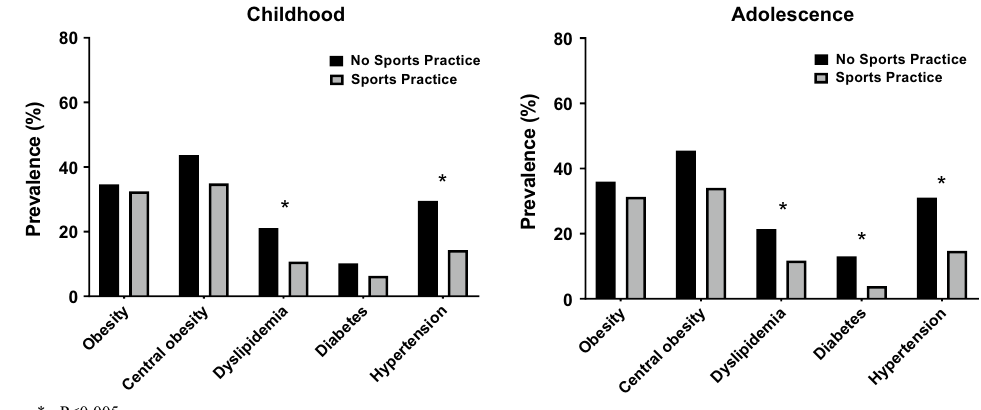
Fig. 1 Prevalence of cardiovascular risk factors in adulthood according to sports practice in childhood and adolescence. * p < 0.005